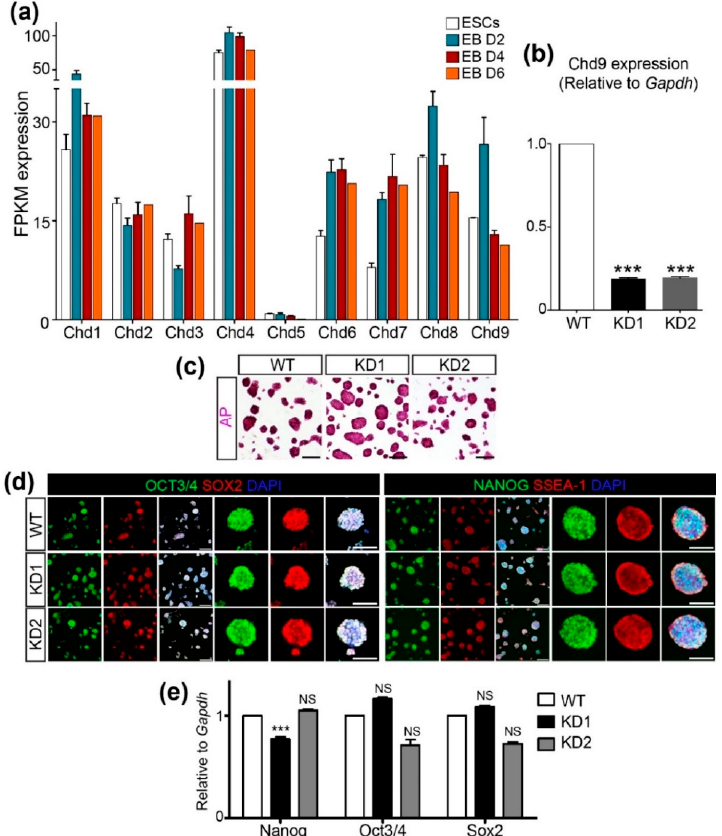
Figure 1. Chromodomain-helicase-DNA-binding (CHD)9 is dispensable for the pluripotency of embryonic stem cells (ESCs). ( a ) Expression values of the CHD family ( Chd1 to Chd9 ) in the ESCs and differentiated cells after 2, 4, and 6 d using RNA-Seq data (GSE114219). FPKM; Fragment per kilobase of transcript per million mapped reads. ( b ) shRNA-mediated Chd9 KD e ffi ciency in the ESCs was confirmed using qRT-PCR (n = 3). ( c ) ESCs were stained to screen for pluripotency through alkaline phosphatase activity. ( d,e ) The expression of the pluripotent markers (NANOG, OCT3 / 4, SOX2,